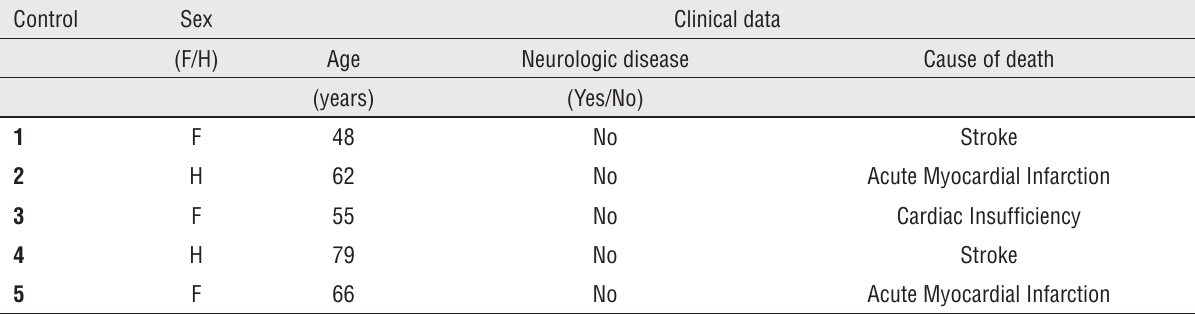
Table 2 - Clinical data of cadaveric donors. Control Clinical data Neurologic disease Cause of